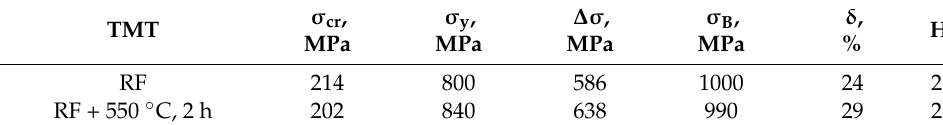
Table 6. Mechanical properties of TiNiHf rods after RF and RF + PDA at 550 ◦ C for 2 h.